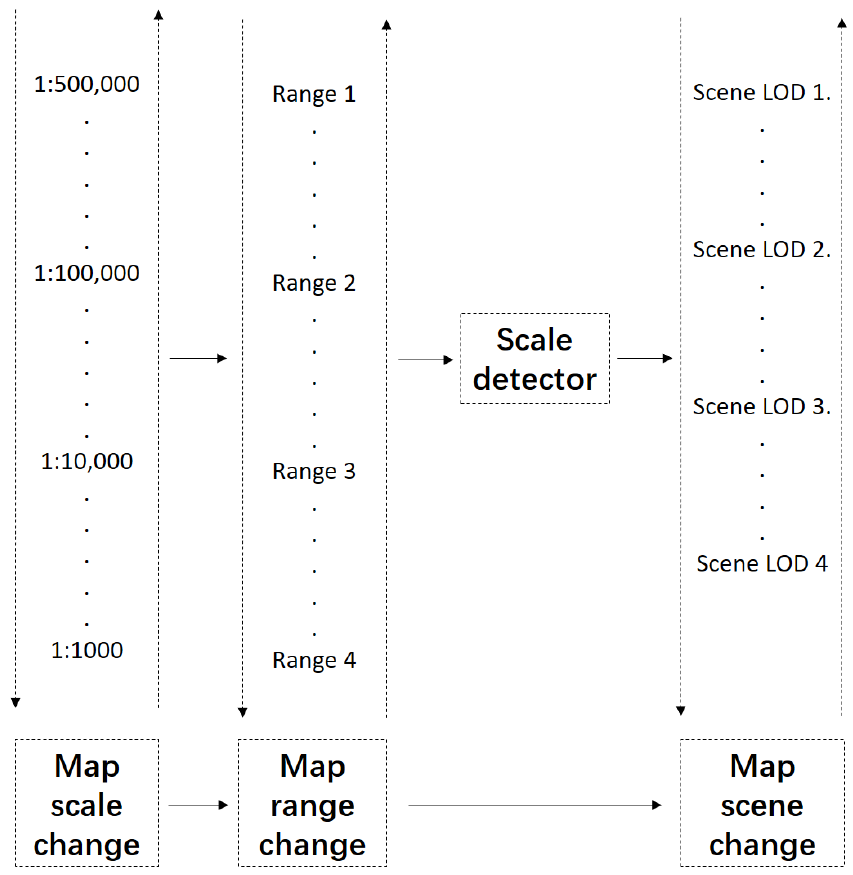
Figure 16. Dynamic relationship between the map scale, map range and map scene.